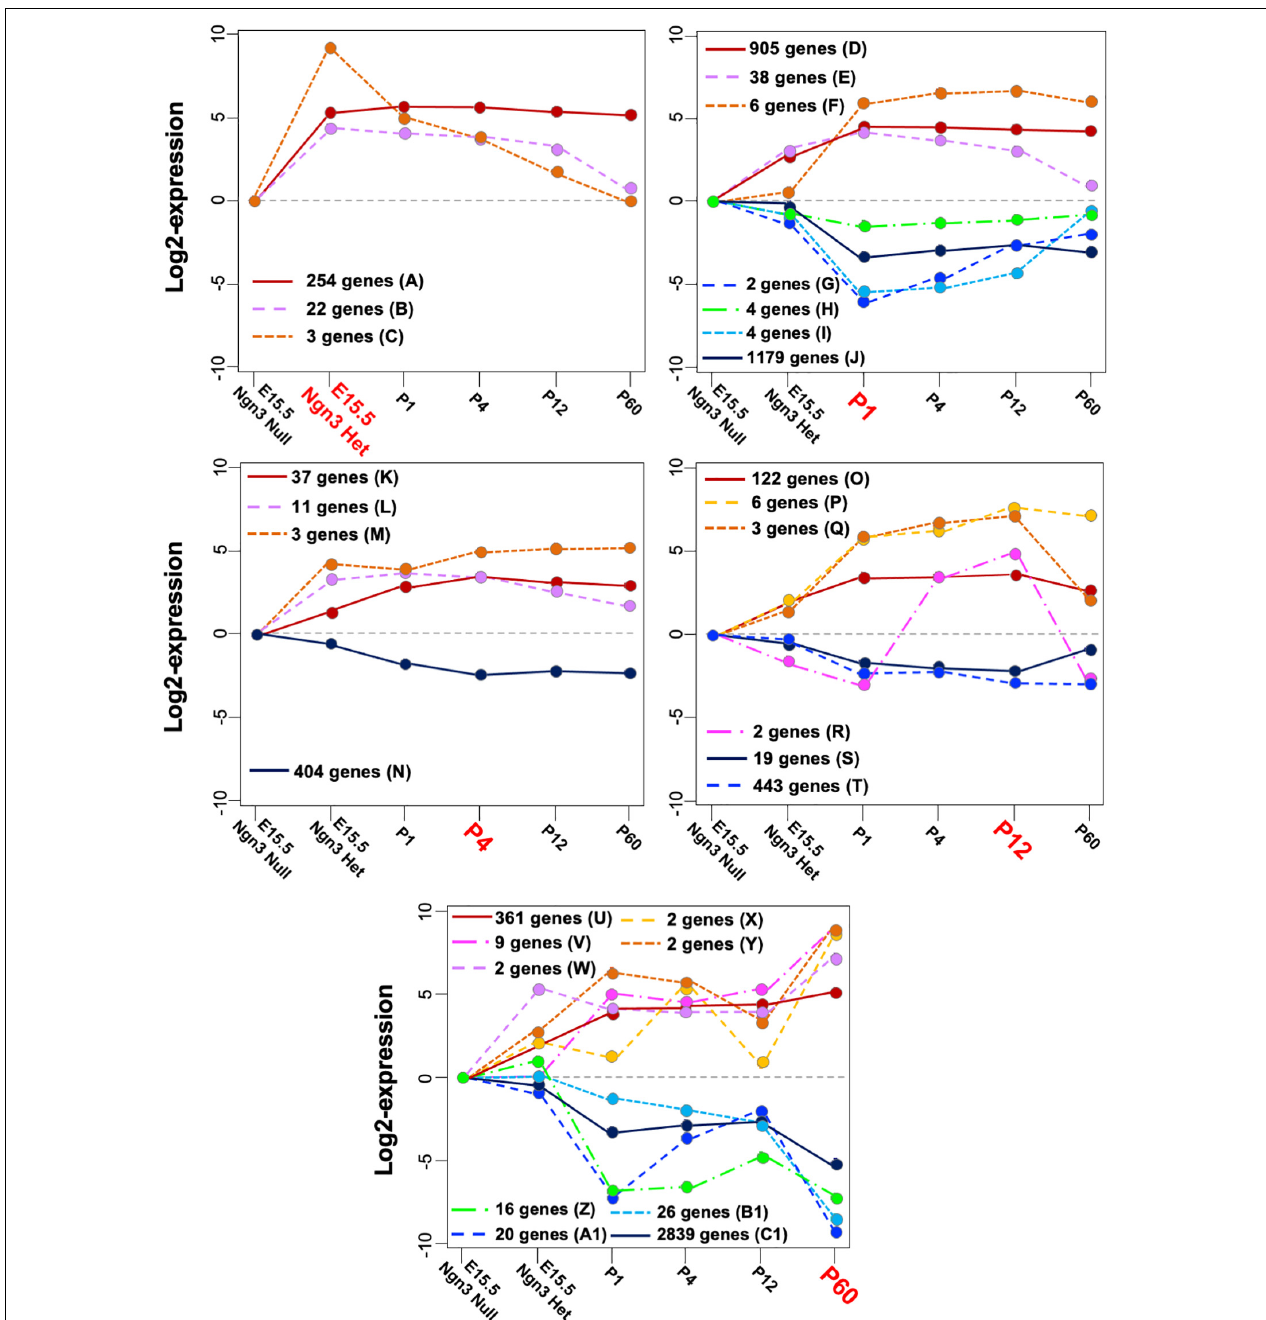
FIGURE 3 | Mature patterns (MPs) identified in maturing β cells. Positive and negative MPs classified according to their time break (highlighted in red) and the dynamic expression across all stages. Note that the line y = 0 represents the basal gene expression at E15.5 in Ngn3 eGFP / eGFP cells that do not express endocrine specific genes. The capital letters are referred to in the MP description in Supplementary Table 1 and in the main